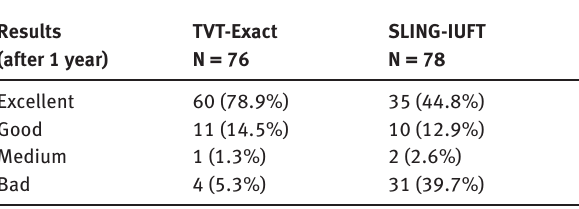
Table 3: TVT-Exact and SLING-IUFT procedures follow-up results.